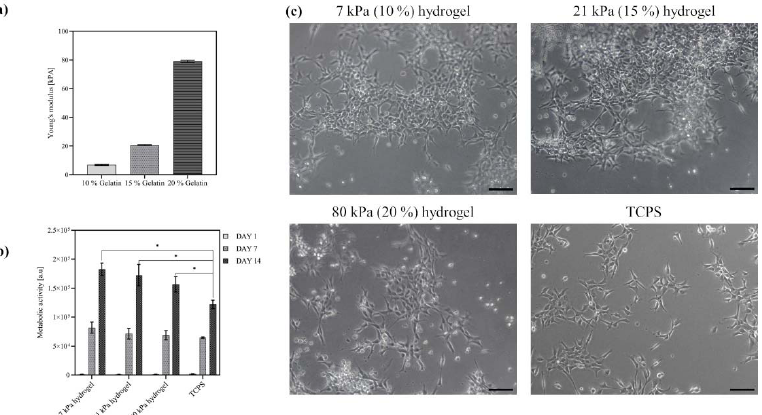
Figure 2. Gelatin hydrogels of variable stiffness support adhesion and proliferation of neural progenitor cells. ( a ) Elastic modulus [kPA] of transglutaminase ‐ crosslinked gelatin hydrogels (10%, 15%, 20% w/w ) at 37 °C, number of hydrogels N = 9; ( b ) Metabolic viability (determined by Alamar Blue assay) of ReN VM cells proliferated for 14 days on gelatin hydrogels; unpaired t ‐ test ( α < 0.05, N = 9); ( c ) Committed neurons at day 7 after differentiation from neural progenitor cells on 7 kPa, 21 kPa, 20 kPa gelatin hydrogels and TCPS control, scale bar = 100 μ m. * p < 0.05.